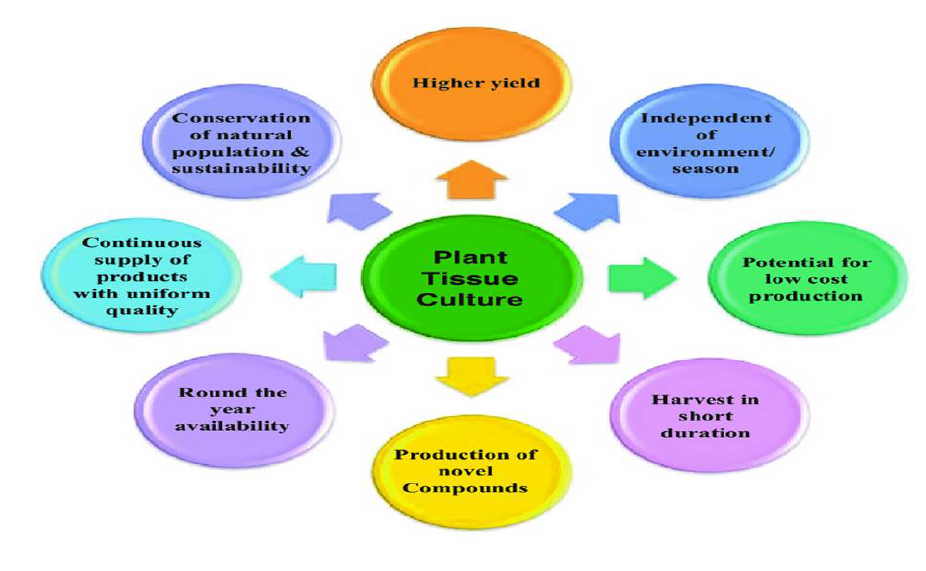
Figure 3: Applications of Plant tissue culture The in-depth information on the use of plant tissue culture (Figure: 3) is provided below- Transgenic plants in